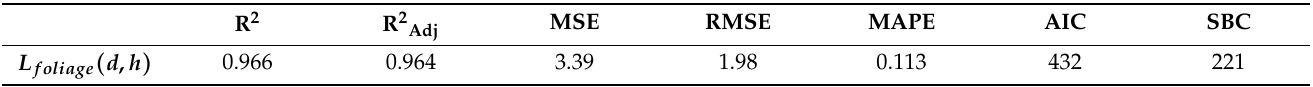
Table 1. Statistical Quality Assessment of the proposed deep learning model. R